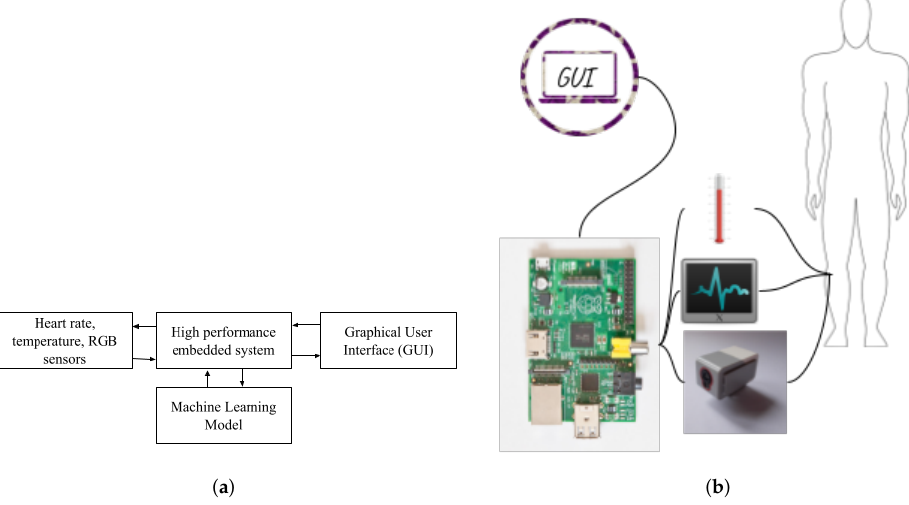
Figure 6. Suggested usage scenario. ( a ) Block diagram of proposed system and ( b ) proposed system